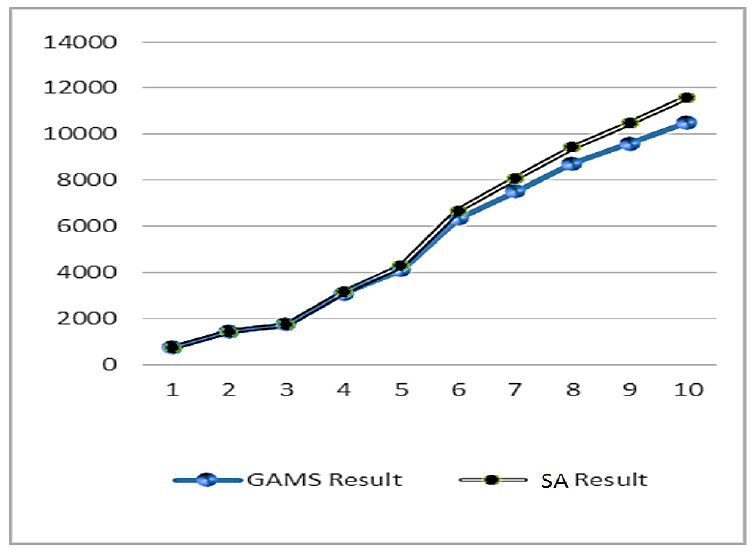
Figure 1. Compare the results of problem solving with GAMS and SA